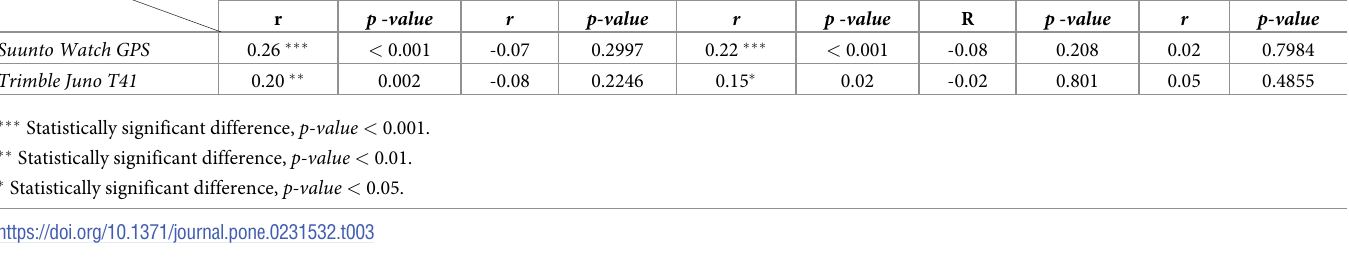
Table 3. Summary of Pearson correlation coefficients for RMSE and meteorological factors. Env. factors